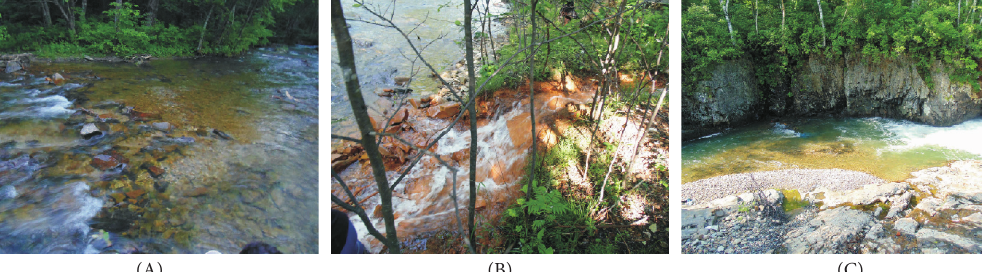
Figure 7: The diagram of changes in the content of iron, zinc, manganese, copper, aluminum, and sulfate anion in the Rudnaya river under the influence of the drainage from the “old” tailings pond of KCM: (a) Rudnaya river above the discharge; (b) point of discharge; (c) below the